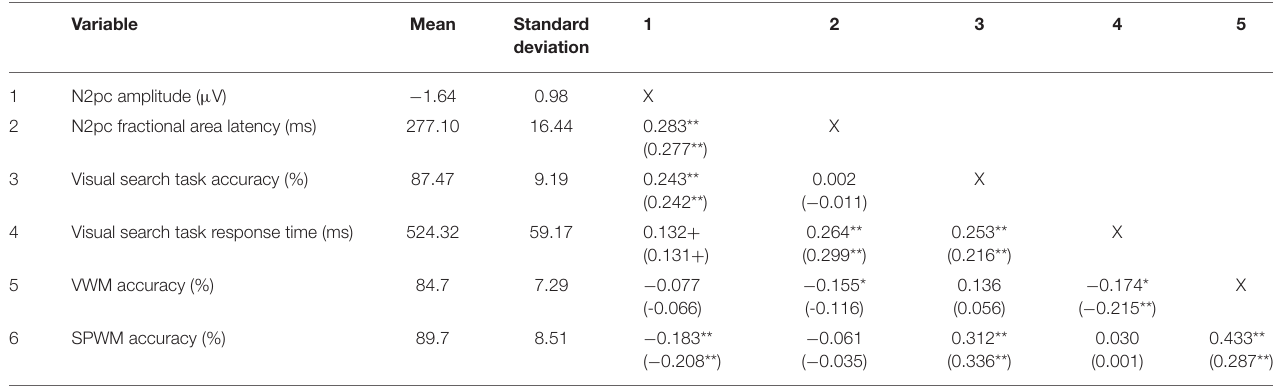
TABLE 1 | Means, standard deviations and correlations of behavioral and ERP measures.